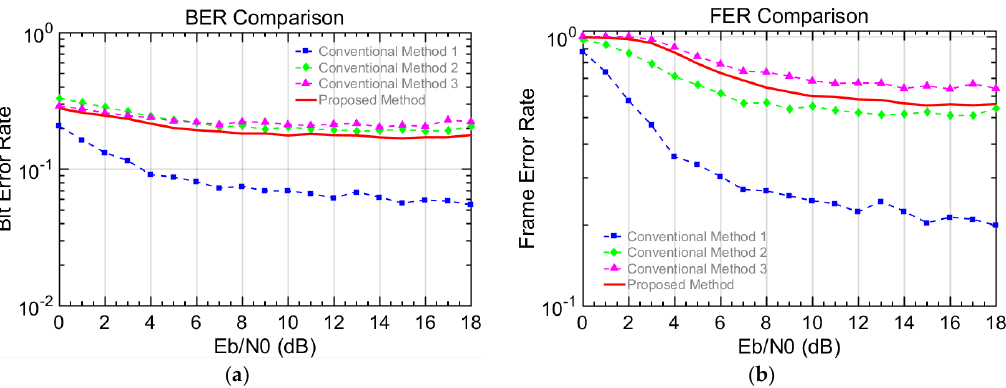
Figure 6. Error rate performance of V2V scenario II in a Rician fading channel with various K-factor values: the ( a ) BER performance and the ( b ) FER performance.